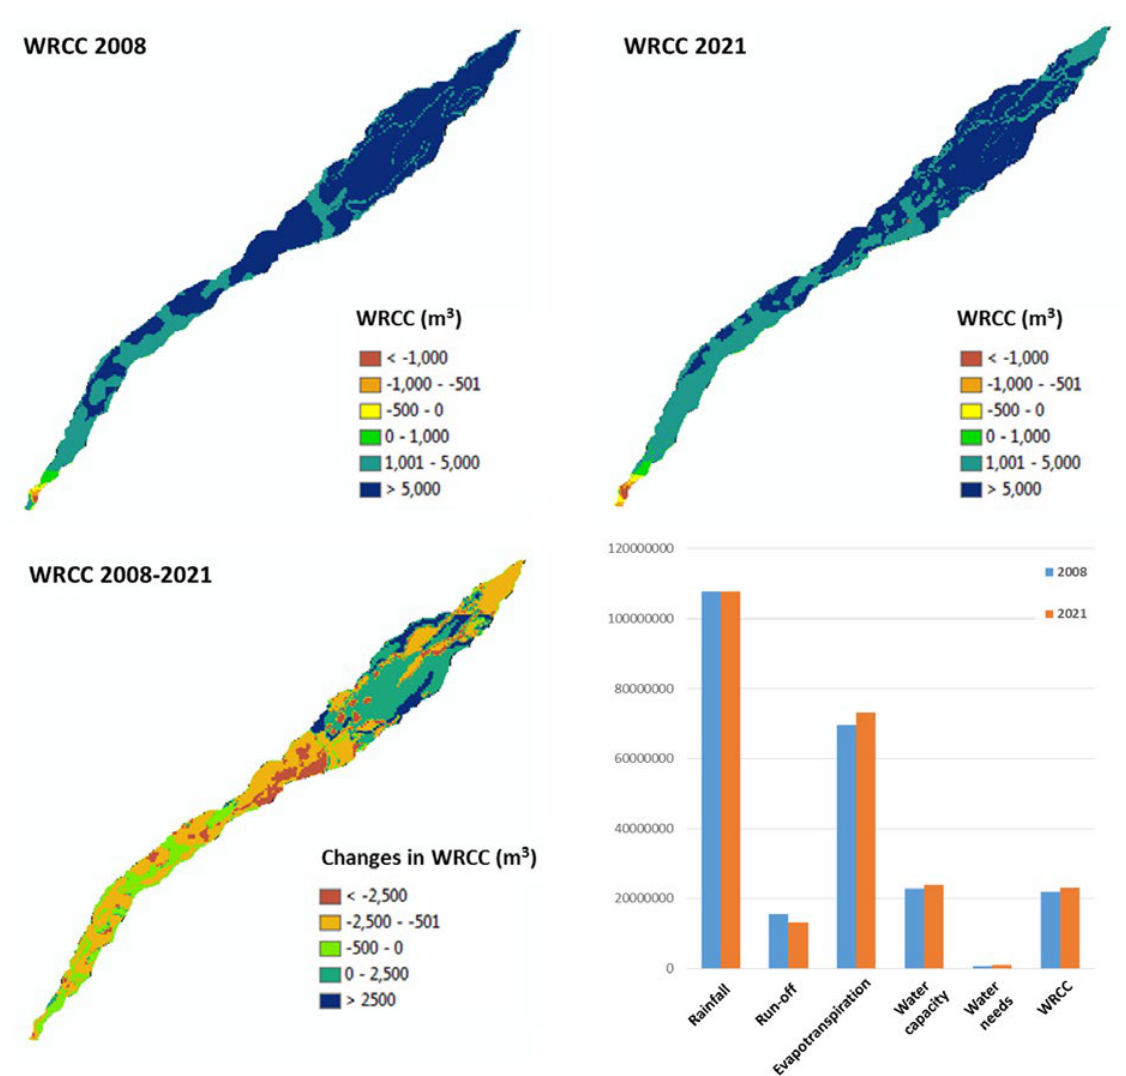
Fig. 3: WRCC Changes in Krasak